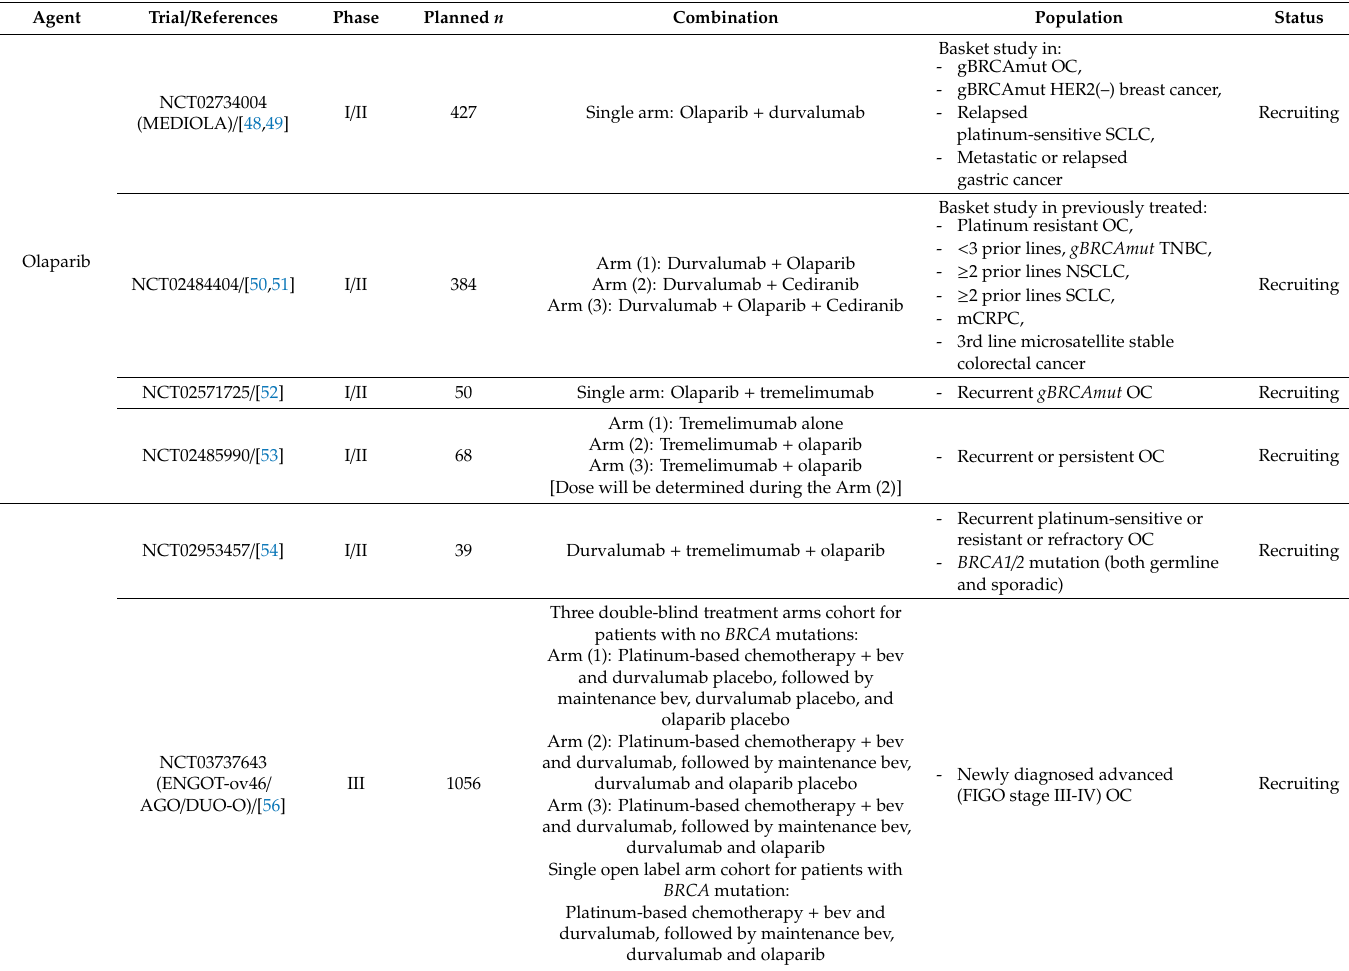
Table 2. Ongoing combination trials with PARP inhibitors and immunotherapy